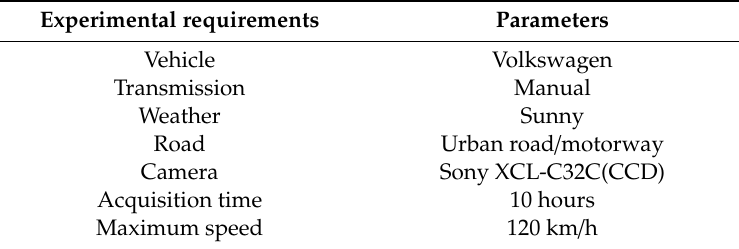
Table 1. Parameters of real vehicle experiment.